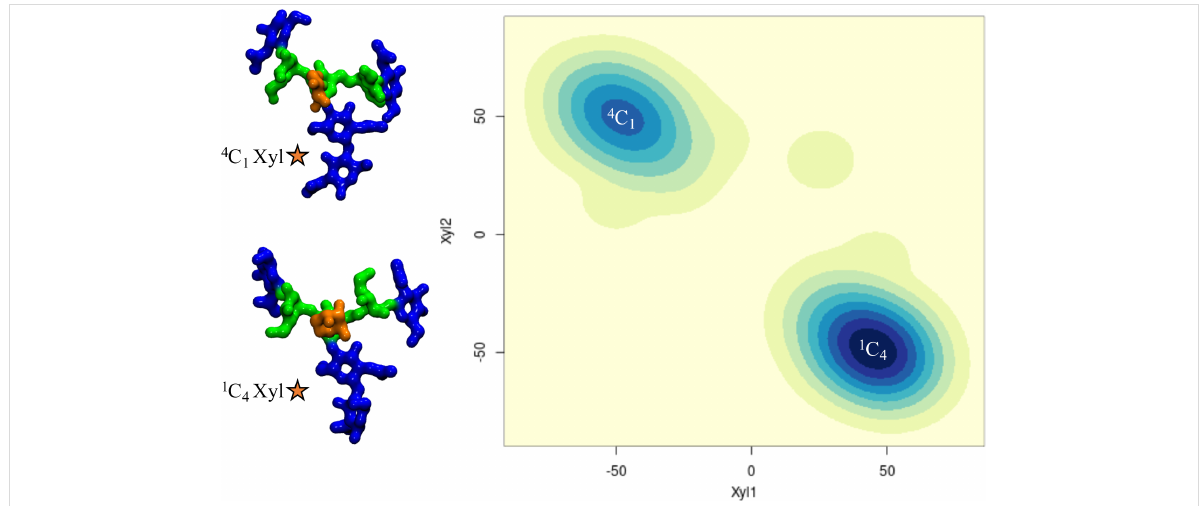
Figure 3: β -D-xylose ring pucker analysis over 3 μ s of cumulative MD sampling of the ngx N-glycan. The two snapshots on the right-hand side are representative ngx conformations corresponding to the two different ring puckers. The Xyl1 and Xyl2 axis labels refer to the torsion angles C1–C2–C3–C4 and C2–C3–C4–C5, respectively. The N-glycan structures are shown with the (1-3) and (1-6) arms on the left and on the right, re- spectively. The monosaccharides colouring follows the SFNG nomenclature. The structure rendering was done with VMD